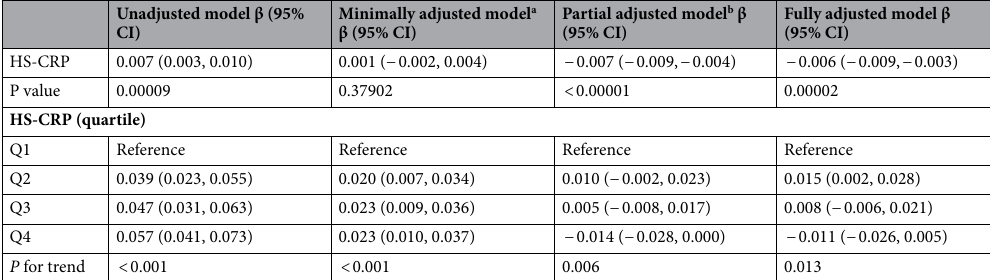
Table 2. Association of HS-CRP with BMD. Unadjusted model adjust for: None. Minimally adjusted model a adjust for: age, gender, race. Minimally adjusted model b adjust for: age, gender, race, BMI, income-poverty ratio, education level. Fully adjusted model adjust for: age, gender, race, BMI, income-poverty ratio, education level, alkaline phosphatase, cholesterol, calcium, phosphorus, globulin, and total protein.